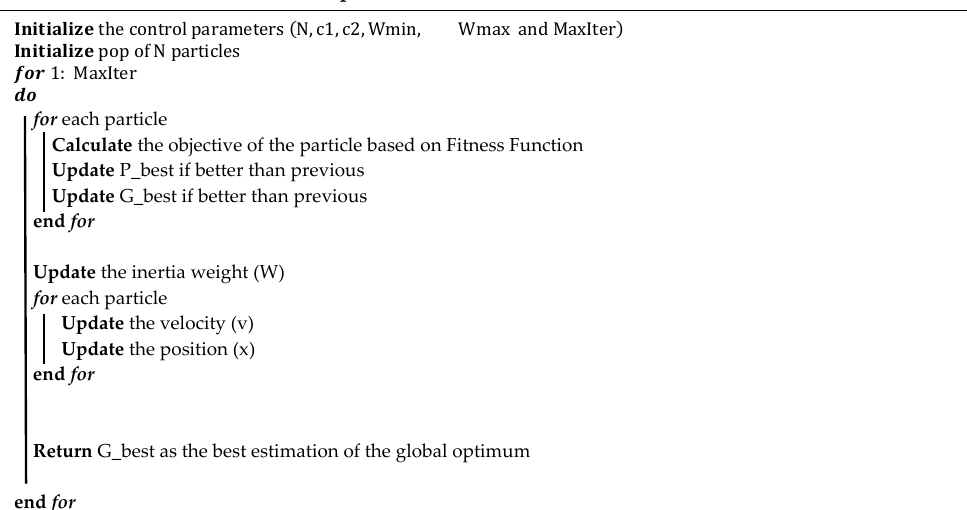
Pseudocode 1: Particle Swarm